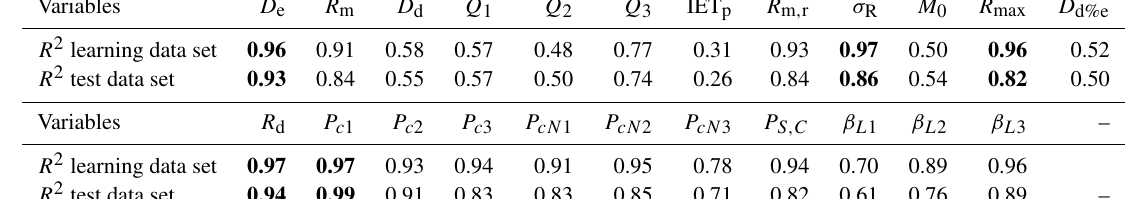
Table 4. Coefficient of determination obtained on the learning and test data sets. The values in bold correspond to the five selected variables. Variables